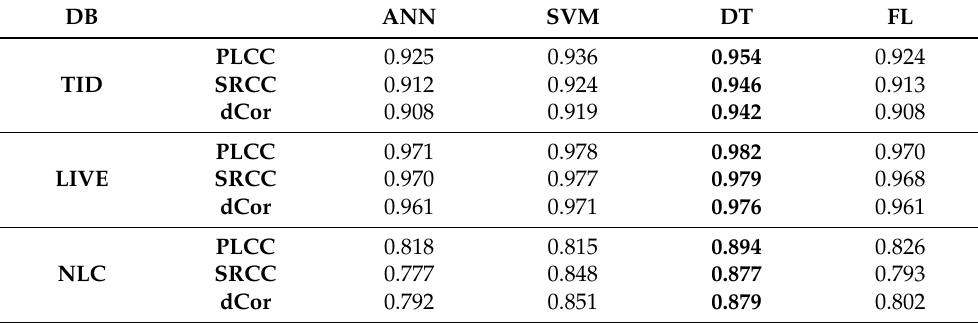
Table 7. Correlation score of MOS vs. estimated image quality of different image databases using different ML methods for